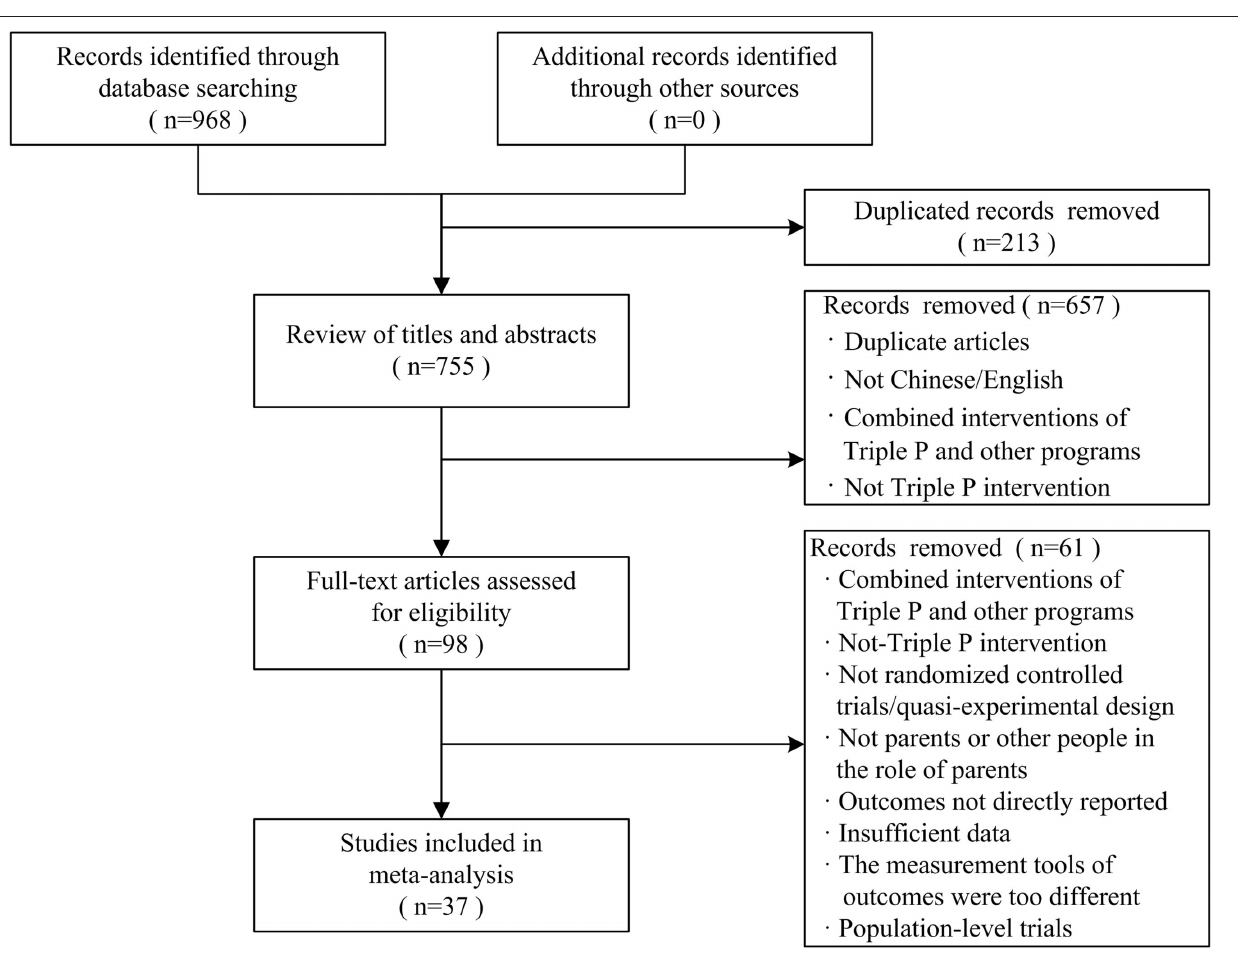
FIGURE 1 | The process of the exclusion and the selection of studies in